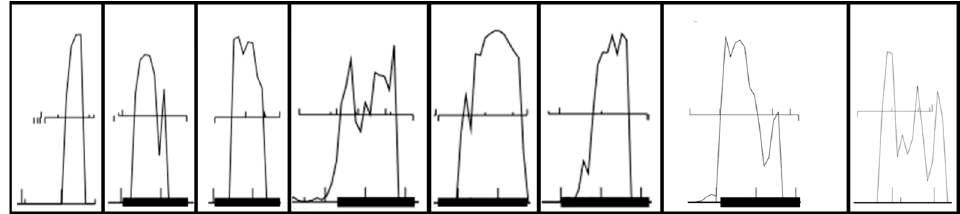
Figure 2. Coding potential of the eight open reading frames (ORFs) identified as coding in the randomly generated DNA sequence by our manual curation method. Six of these were identified as coding by GeneMark.